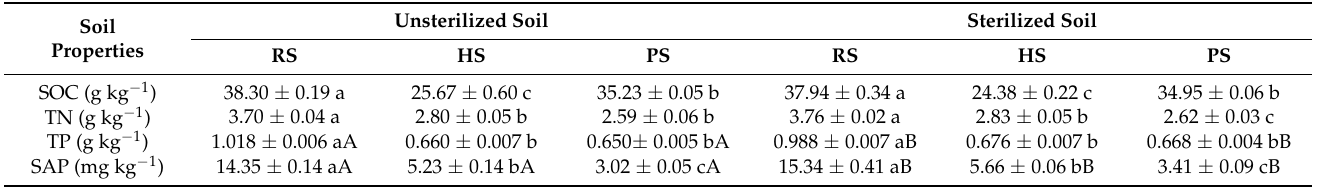
Table 1. Soil chemical properties of the three different unsterilized and sterilized soils used in the glasshouse experiment (mean ± 1 SE, n =